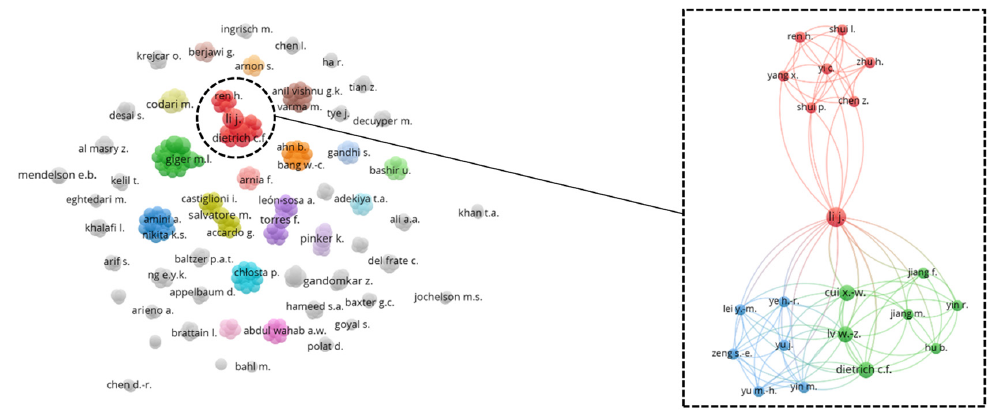
Figure 12. Co-authorship bibliographic network analysis: author.